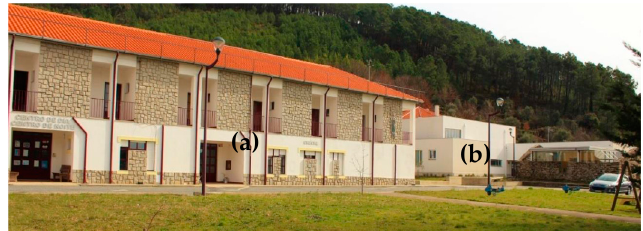
Figure 1. Social and Cultural Center of Santo Aleixo: ( a ) residential building; ( b ) building of new valences.